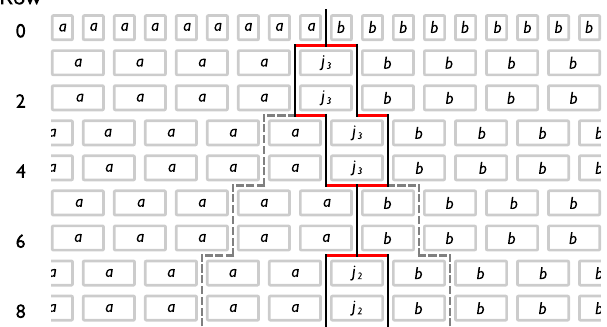
FIG. 19. A leading-order DW diagram in the block represen- tation for h exp ½ − 2 S 3 ð t Þ(cid:2)i in the large- q limit. The order is given by q − 2 h ab − h aji − h jib , where h c counts the horizontal walls 1 c 2 between c 1 and c 2 contractions in red.